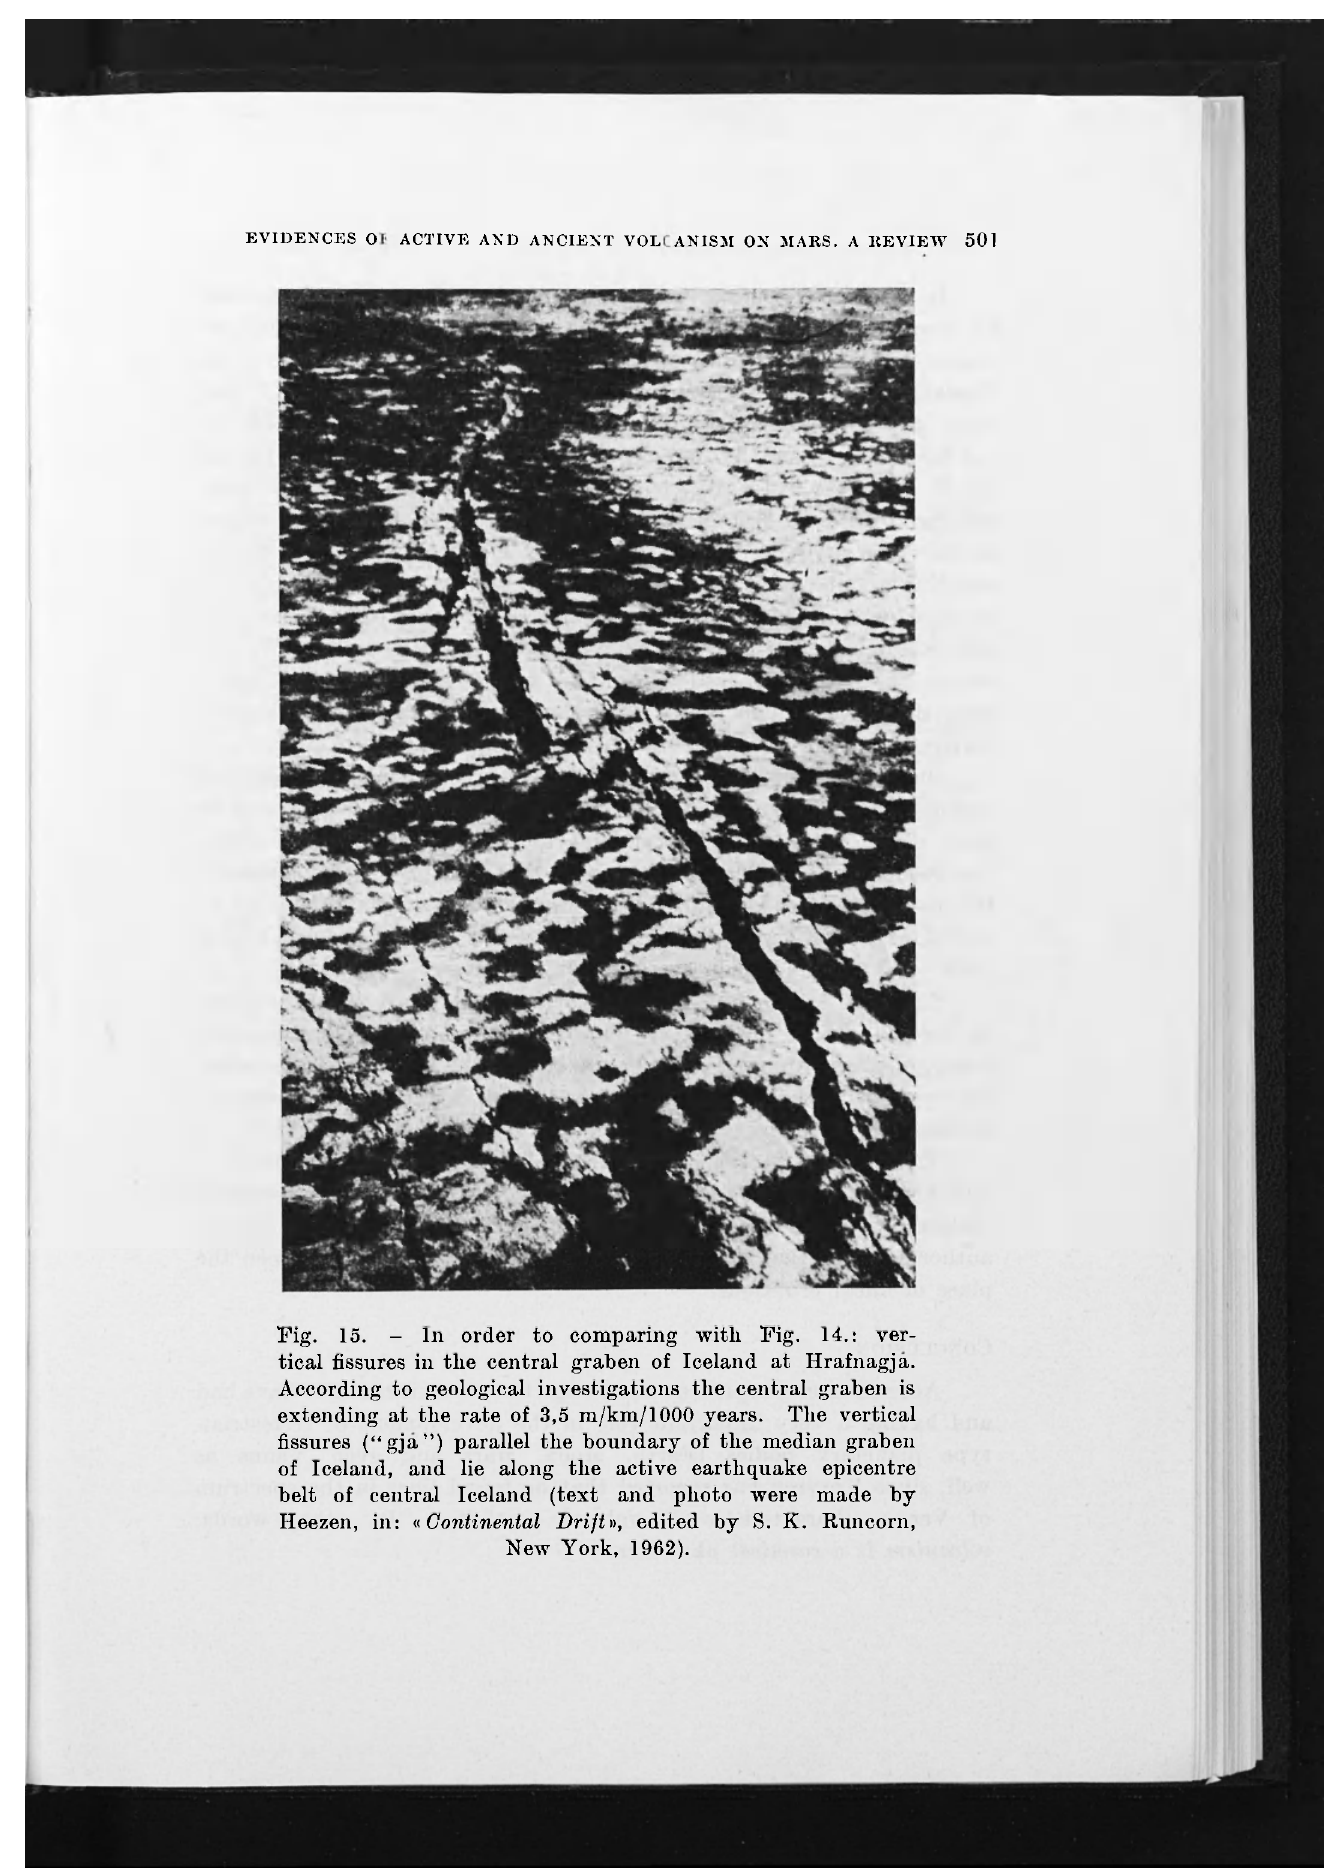
Fig. 15. - 111 order to comparing with Fig. 14.: ver- tical fissures in the central graben of Iceland at Hrafnagja. According to geological investigations the central graben is extending at the rate of 3,5 m/km/1000 years. The vertical fissures ("gja") parallel the boundary of the median graben of Iceland, and lie along the active earthquake epicentre belt of central Iceland (text and photo were made by Heezen, in: « Continental Drift», edited by S. K. Runcorn, New York,